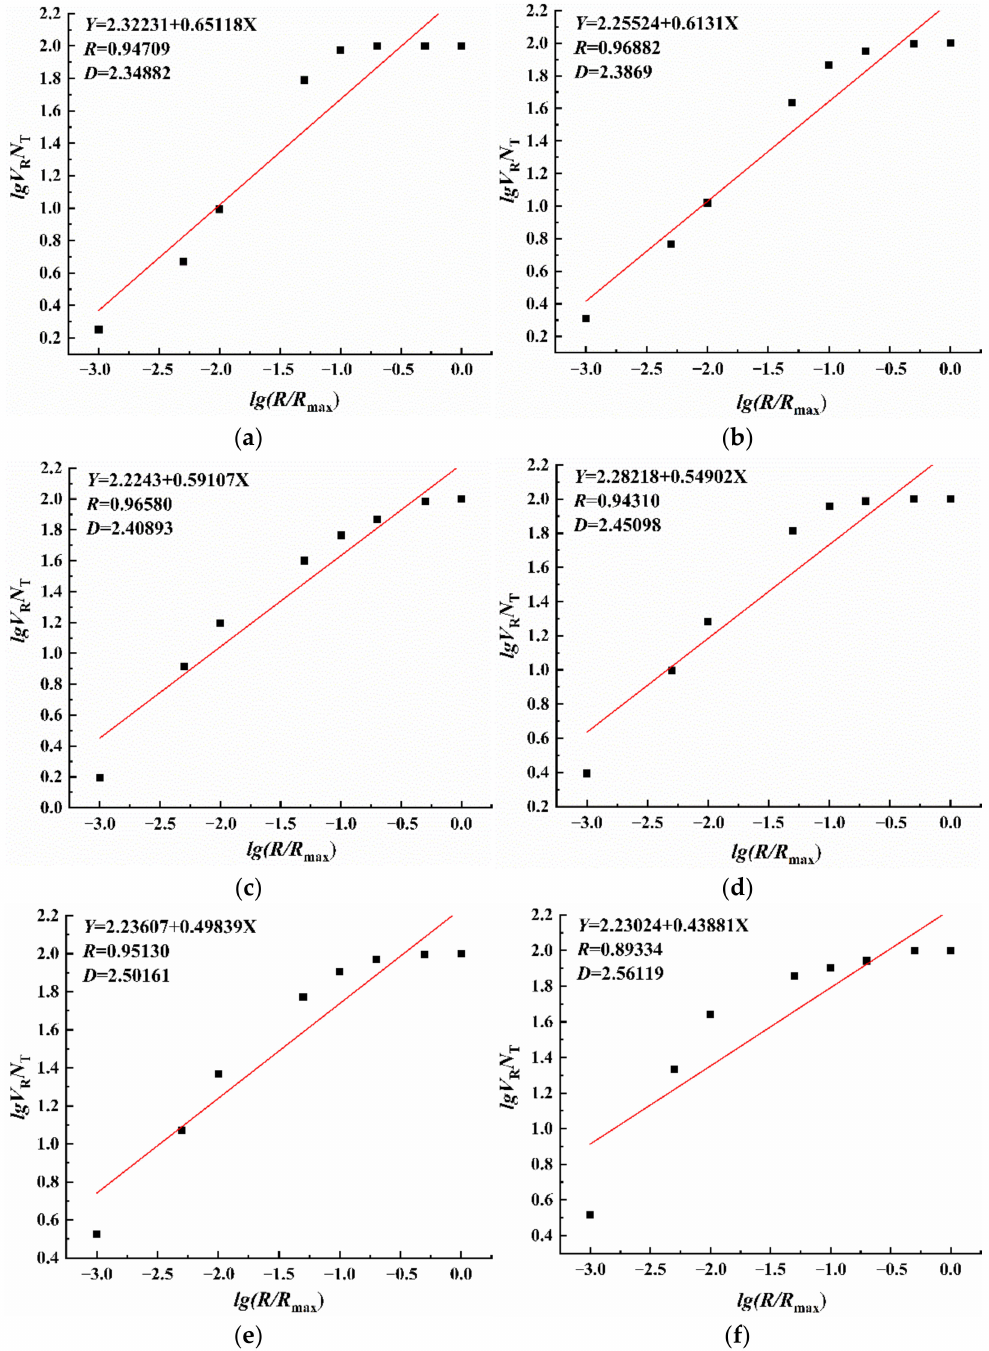
Figure 7. Calculation results for fractal dimension of soil volume: ( a ) Lanzhou loess; ( b ) Songling soil; ( c ) Tahe soil; ( d ) Harbin clay; ( e ) Loam; ( f ) Genhe red